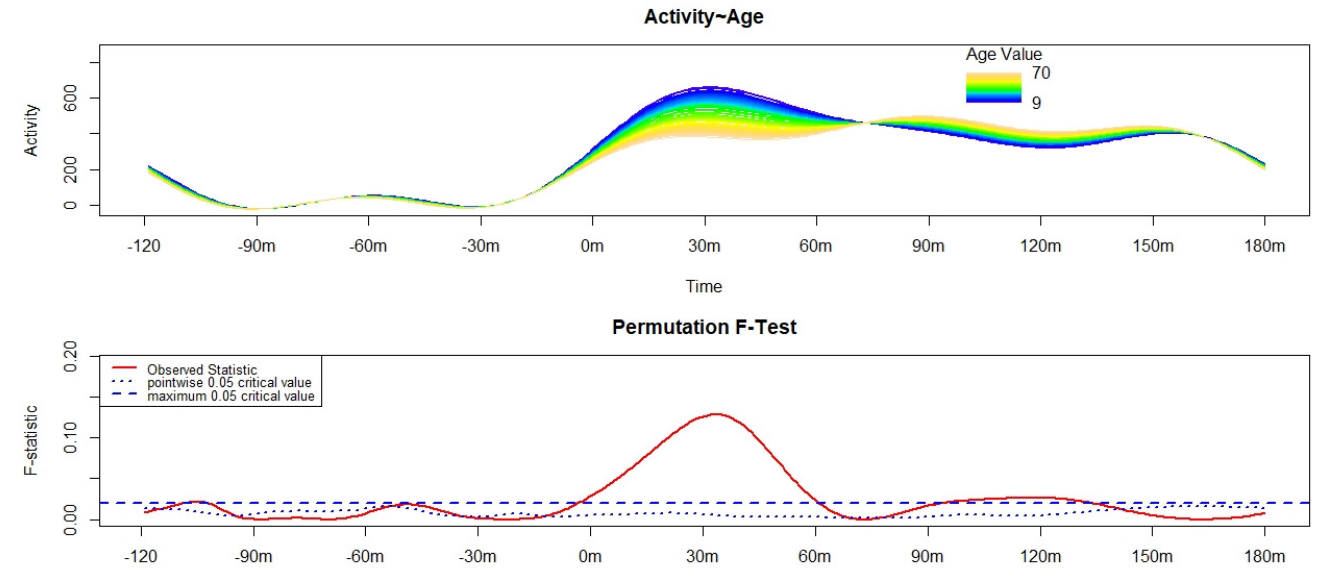
Figure 1. Results of the Functional Linear Modeling applied to the analysis of the variation in the motor activity pattern of sleep-wake transition [starting from 120 min before ( − 120 m) the get-up time (0 m) up to 180 min after (180 m) the get-up time] according to age. The upper panel shows the estimated activity pattern according to age, with different colors depicting the motor activity pattern of sleep-wake transition of participants of different ages. Blue indicates the lowest age, while dark yellow refers to the highest. Activity corresponds to the functional form of raw motor activity data. The lower panel shows the results of the non-parametric permutation F-test. Significant differences can be observed when the solid red line is above the dashed blue line (i.e., the global test of significance, the most conservative).